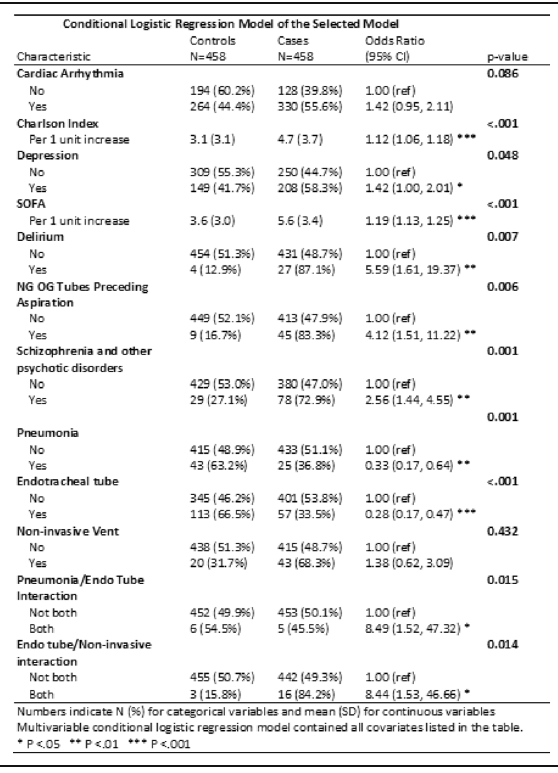
Table 1 (abstract 0001). Conditional Logistic Regression Model of the Selected